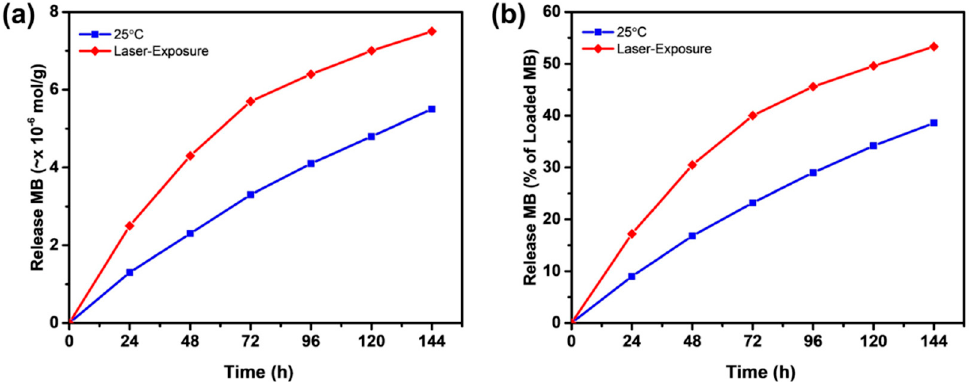
Figure 5. Release profile of MB-loaded GNS@ m -SiO 2 @hydrogel NPs at a constant temperature of 25 ◦ C and after exposure to a near infrared (NIR) laser; ( a ) released MB in terms of concentration (~ × 10 − 6 mol / g) and ( b ) percentage of released MB in terms of the total amount of loaded MB into the hydrogel-encapsulated composite NPs.